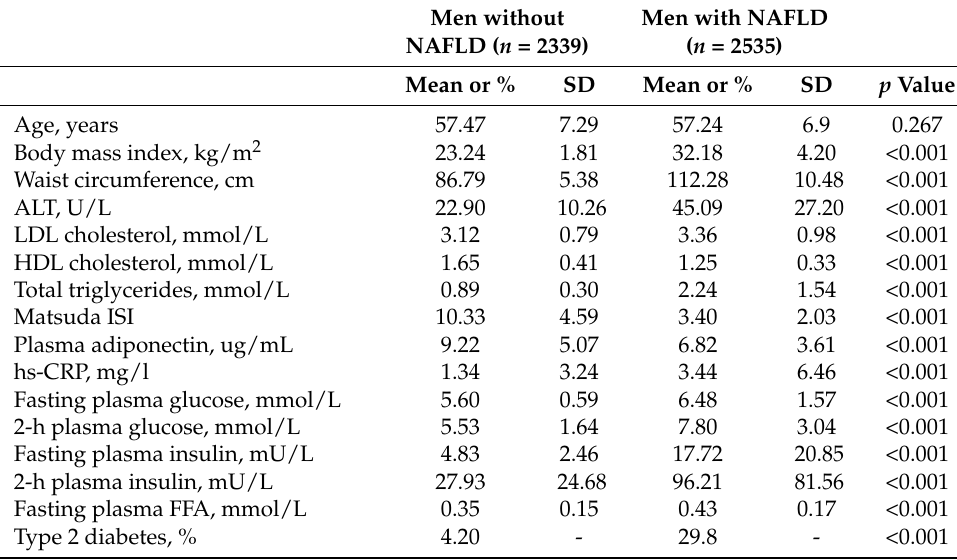
Table 1. Baseline characteristics of men included in the study.